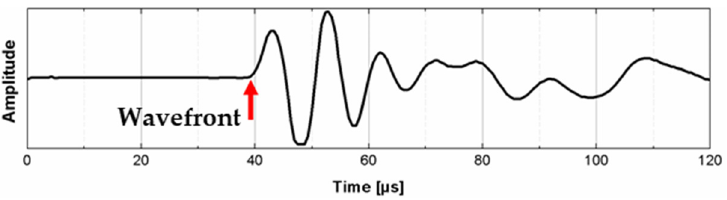
Figure 4. The presentation of registered ultrasonic signal with the indication of the wavefront used to determine the time of wave